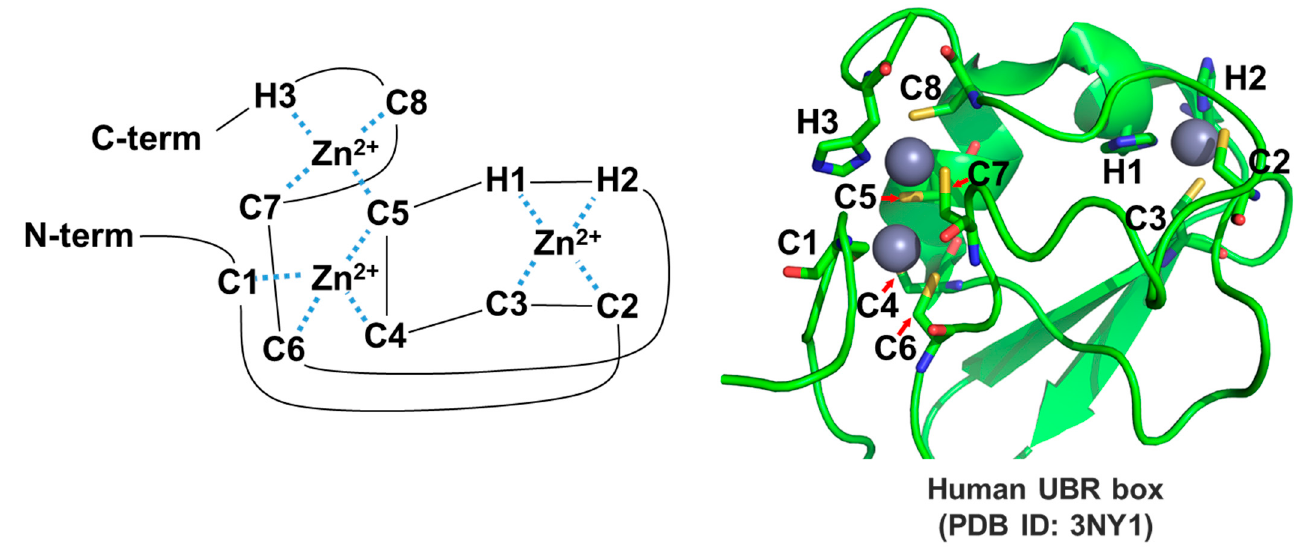
Figure 3. Three-dimensional structures of the UBR box. The UBR box coordinates three zinc ions. Two cysteines (C2 and C3) and two histidines (H1 and H2) coordinate one zinc. Six cysteines (C1, C4, C5, C6, C7, and C8) and one histidine (H3) coordinate the other two zincs.